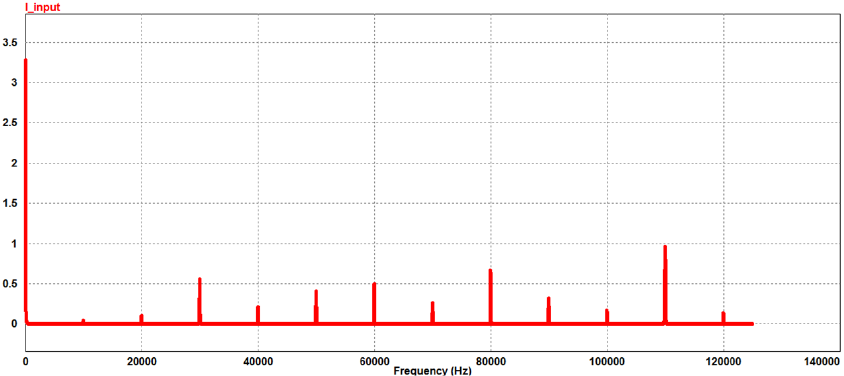
Figure 10. FFT analysis of the input current waveform of an IH system without any filter.